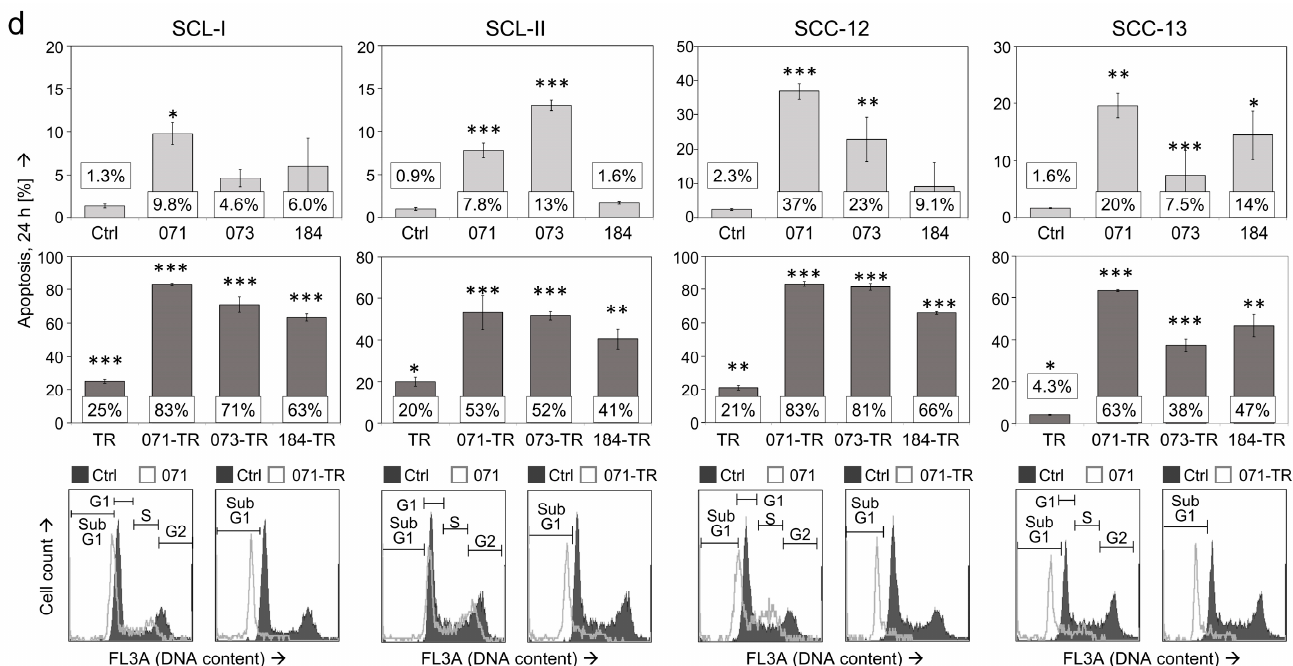
Figure 1. Decreased cell proliferation, cell viability and apoptosis induction. ( a ) Chemical structures of indirubin derivatives DKP-071, DKP-073 and DKP-184 are shown. ( b ) Cell proliferation was quantified by WST-1 assay in four cSCC cell lines at 24 h of treatment with indirubins (DKP-071, -073 and -184, 10 µ M), TRAIL (TR; 50 ng/mL) or the combinations, as indicated. ( c ) Cell viability was determined by calcein-AM staining in cSCC cell lines at 24 h (treatment as above). ( c ) Apoptotic cells characterized by DNA fragmentation were identified by flow cytometry after propidium iodide staining as sub-G1 cells (cell cycle analyses, treatment as above). ( b – d ) Mean values are shown of triplicates of representative experiments (at least two independent experiments, each one with triplicates). ( c , d ) Examples of flow cytometry measurements are provided below (overlays of treated cells vs. controls). ( d ) The percentages of apoptotic cells are also indicated. Asterisks indicate statistical significance, as compared to controls (* p < 0.05; ** p < 0.01; *** p <